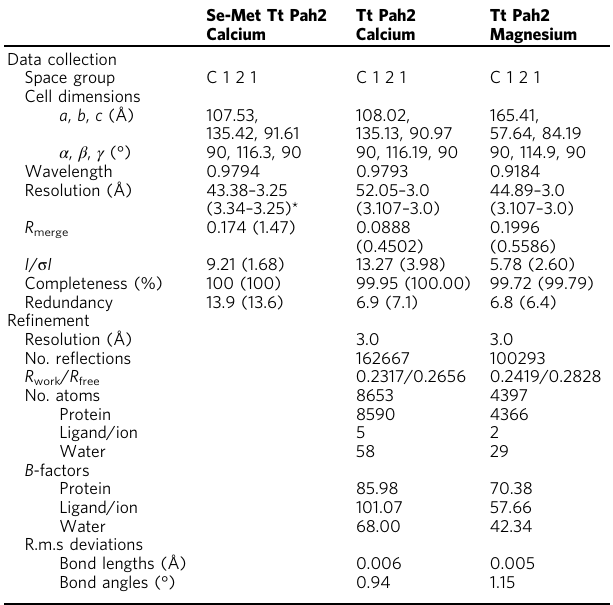
Table 1 Data collection and re fi nement